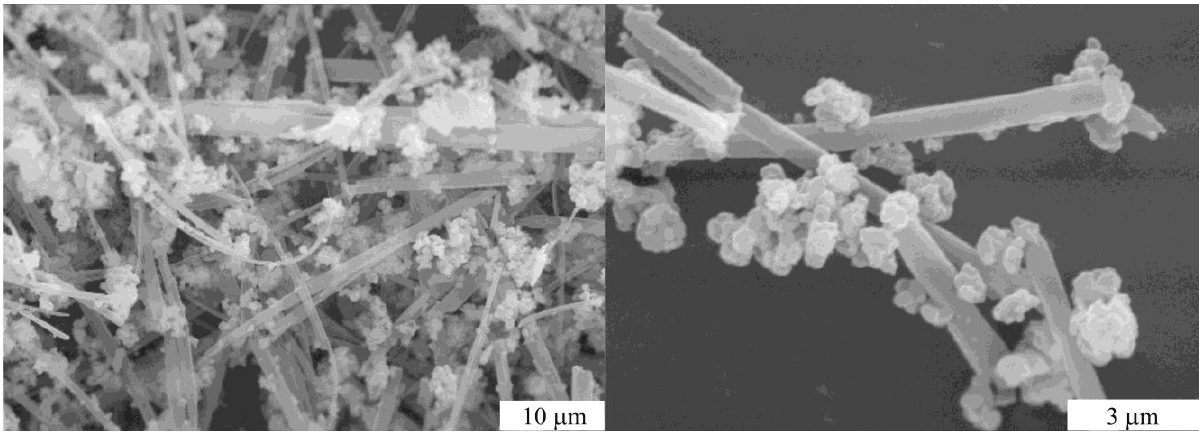
Figure 11. SEM images of the catalyst obtained from NiCl